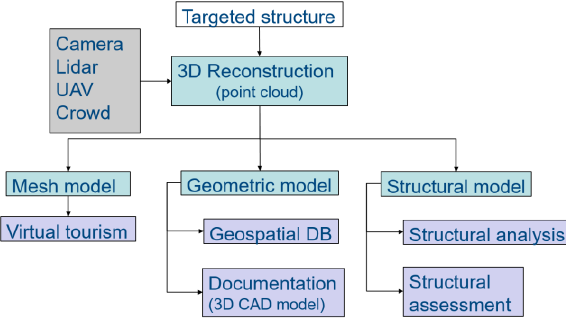
Figure 2. Diagram of photogrammetric reconstruction workflow for heritage structure